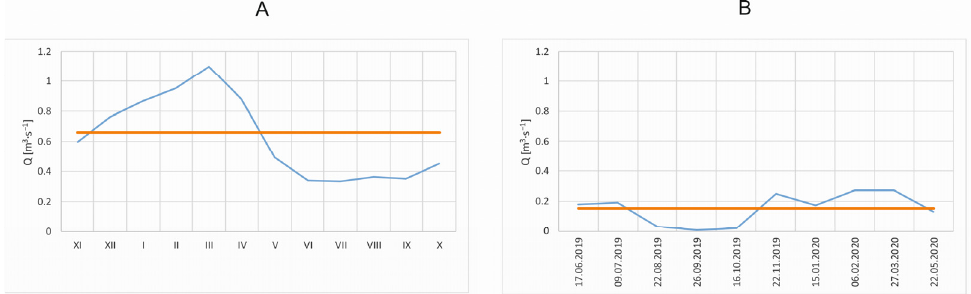
Figure 2. Average monthly-blue line and average annual–orange line flow for Cybina, Antoninek profile in 1976–1980 ( A ) [41]; daily average flow from June 2019 to May 2020-blue line and average of these measurements ( B ) [42].